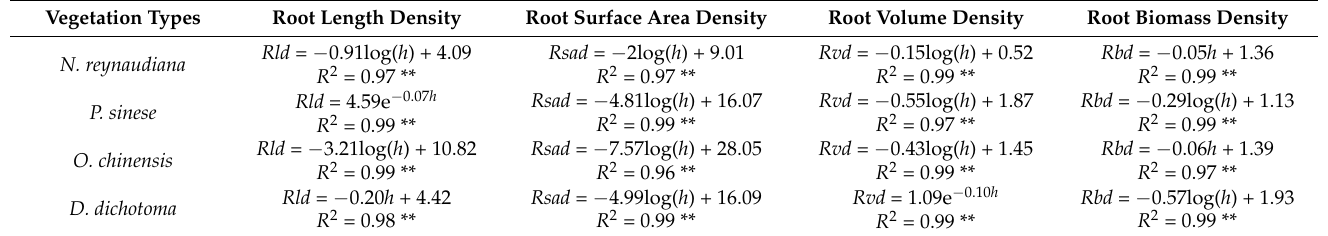
Table 5. The equation of root morphological parameters of four kinds of vegetation types varying with the soil layer ( h